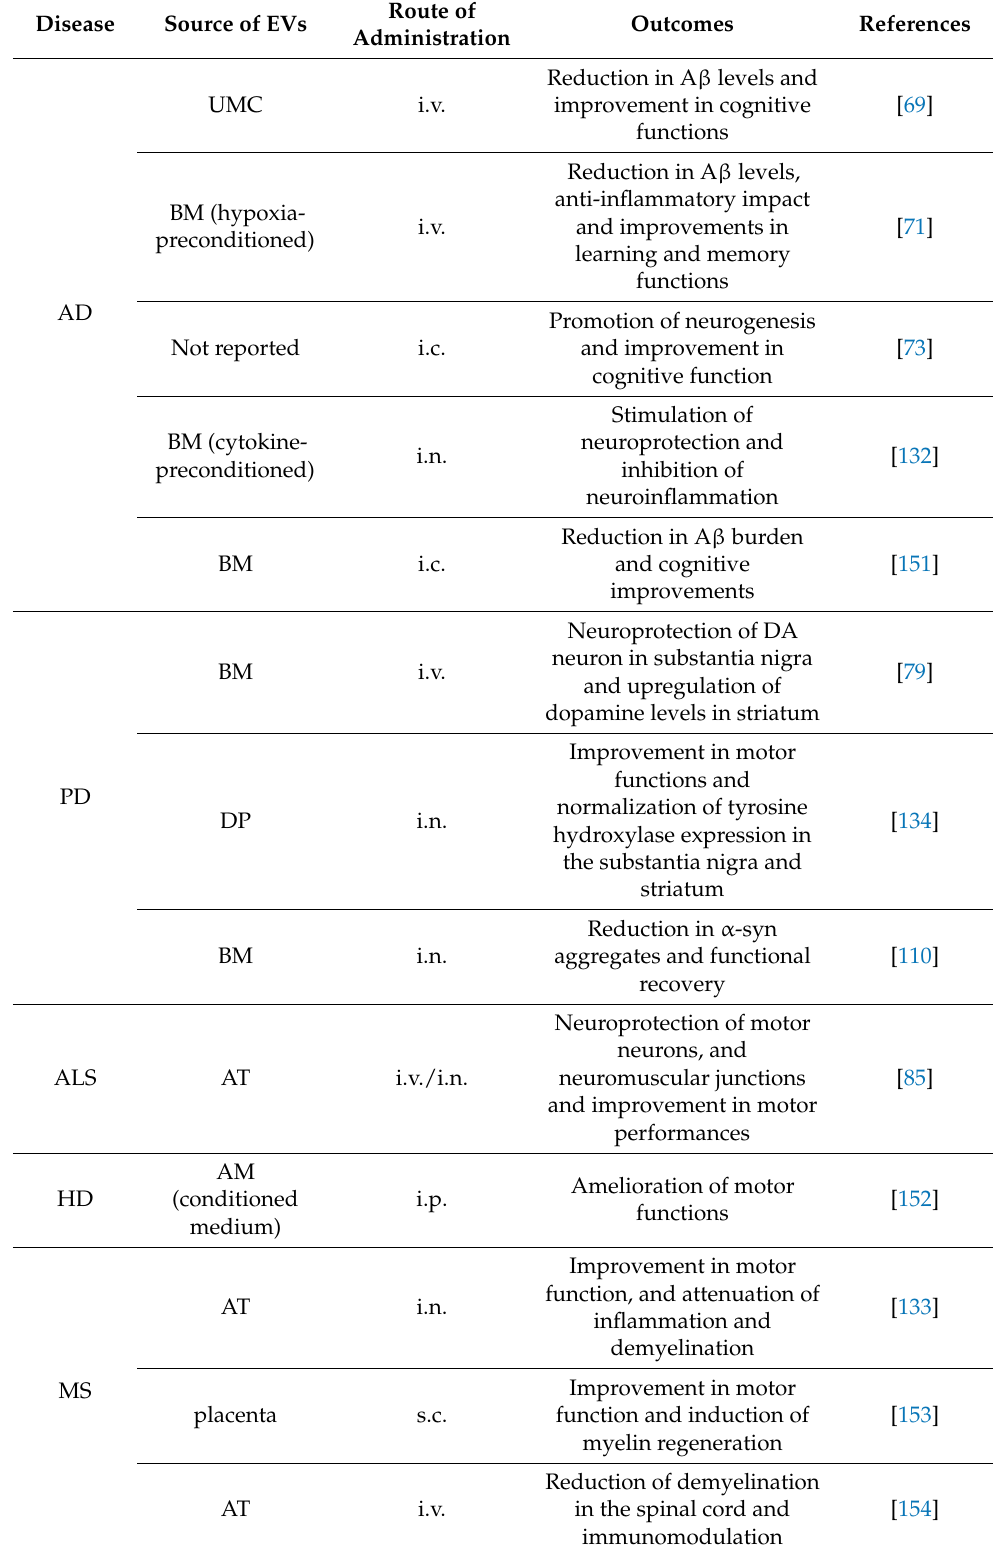
Table 2. Relevant preclinical studies on MSC-EVs in neurodegenerative experimental models.